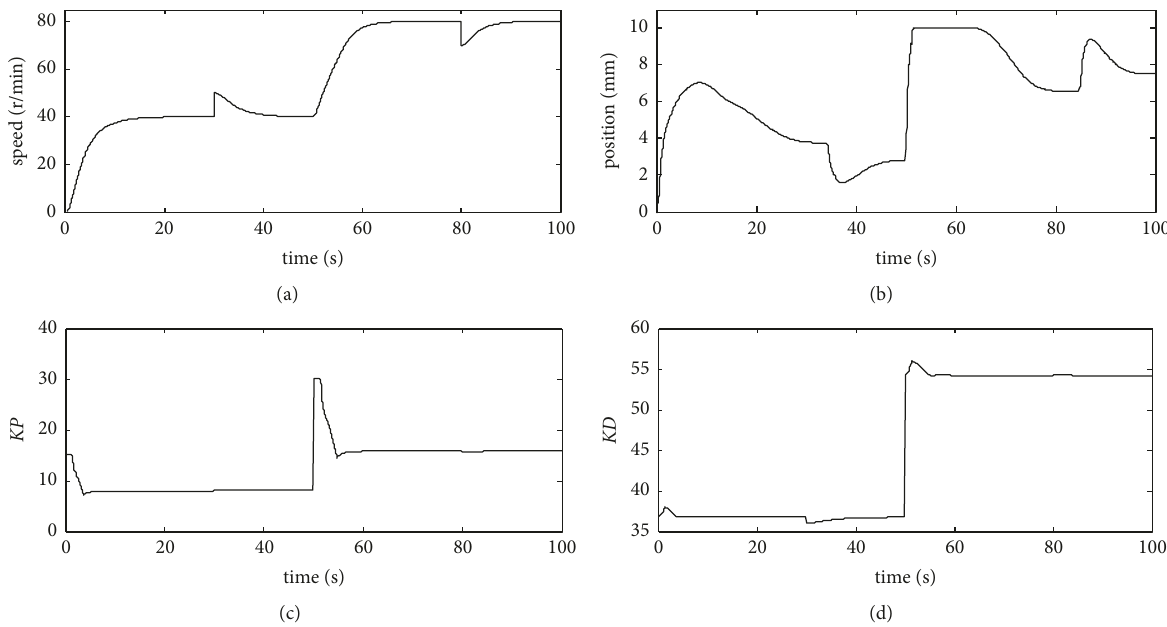
Figure 4: The speed regulation performances (a), fuel index positions (b), and adaptive variation of control parameters ((c)&(d)) at different set speeds with sudden step